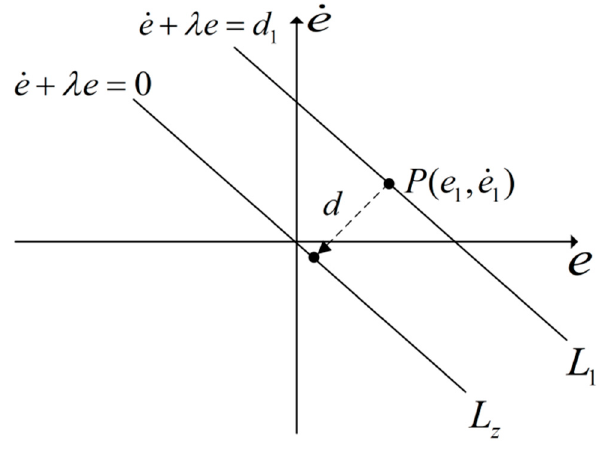
Figure 3. Distance variable.